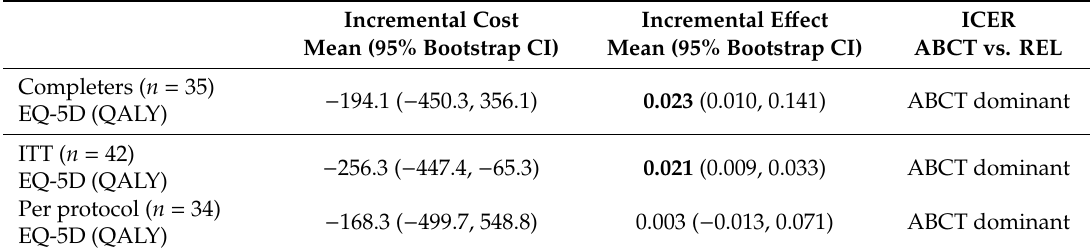
Table 4. Incremental cost, e ff ect, and cost-e ff ectiveness ratios from the healthcare